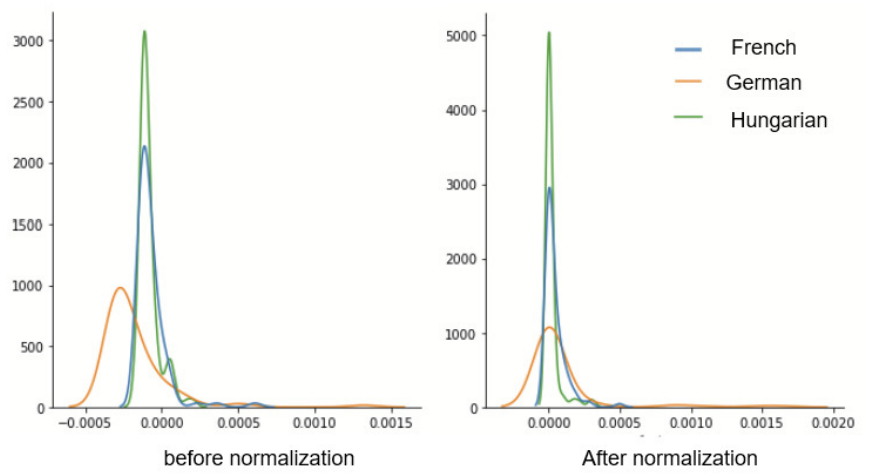
Figure 4. Illustration of the effects of CORAL on the distribution of one MSF feature for French, German, and Hungarian languages. Plots on the left are before normalization, and those on the right are after